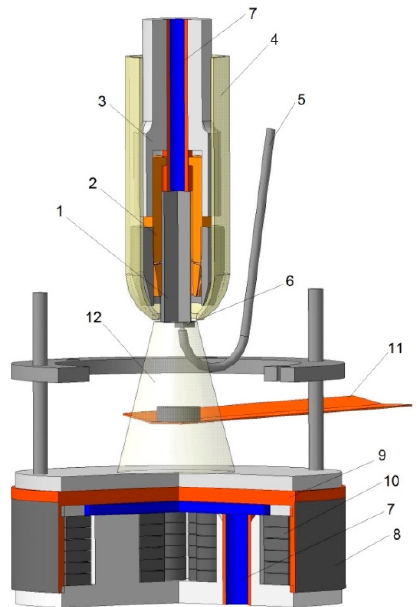
Figure 1. A schematic of the pulsed cathodic arc evaporation (PCAE) method: 1—cathode being evaporated; 2—cathode holder; 3—isolator; 4—quartz tube; 5—ignition system; 6—ceramic; 7—water cooling system; 8—anode case; 9—copper plate; 10—magnet system; 11—substrate holder with a substrate; and 12—coating deposition zone.